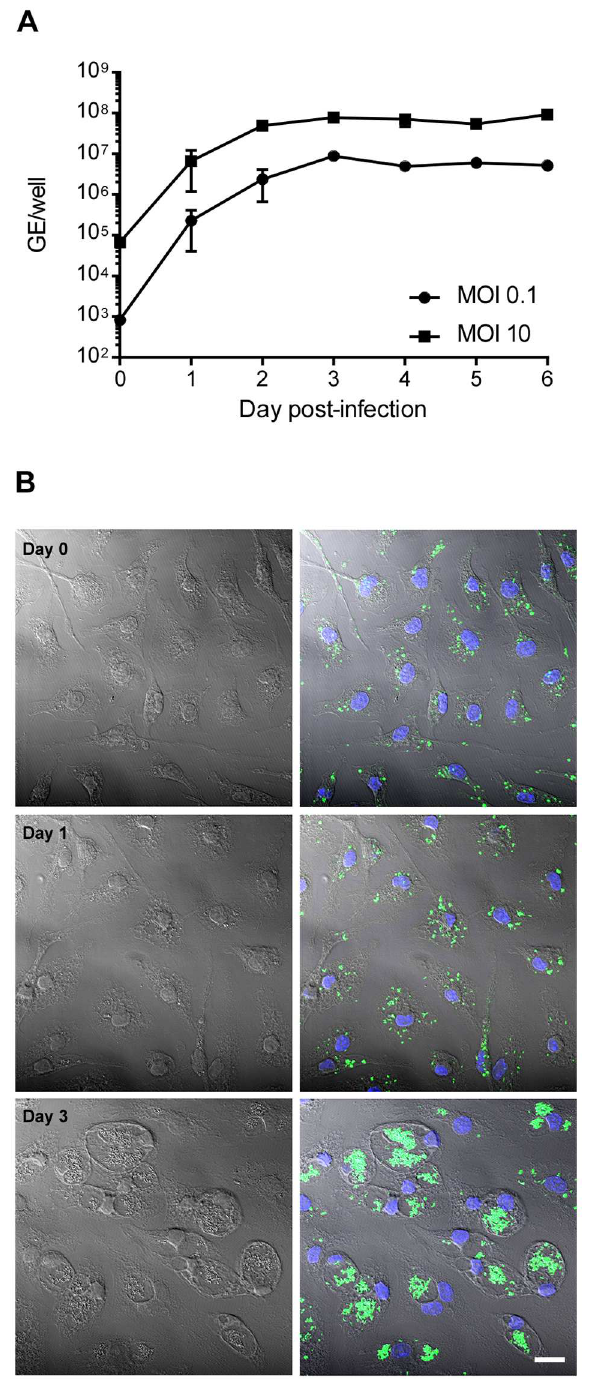
Fig 1. NMII grows robustly in C57BL6/J BMDM differentiated with rmM-CSF. (A) BMDM in 24-wellplates were infected with NMII at an MOI of 0.1 or 10. Bacterial growth was assessedby quantifying genomic equivalents (GE). Results are expressedas the means of three biologicalreplicates from one experiment and are representative of three independentexperiments. Error bars indicate the standarddeviations of the means. (B) BMDM on coverslipsin 24-wellplates were infected with NMII at an MOI of 10. Cells were fixed immediately after infection (Day 0), and at 1 and 3 days post-infection. Cells were stainedfor NMII (green) and DNA (blue), and fluorescent images overlaidwith the corresponding phase contrast image. Bar, 10 μ m.